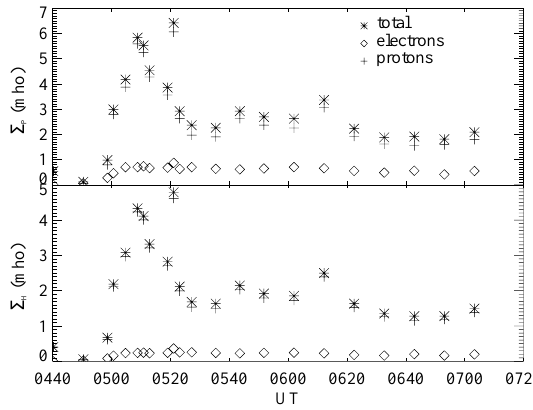
Fig. 9. Time evolution of the Pedersen (top panel) and Hall (bottom panel) conductances during a substorm which occurred on 28 April 2001. The conductances are averaged over the sector between 71 ◦ and 77 ◦ MLAT and 14:00 and